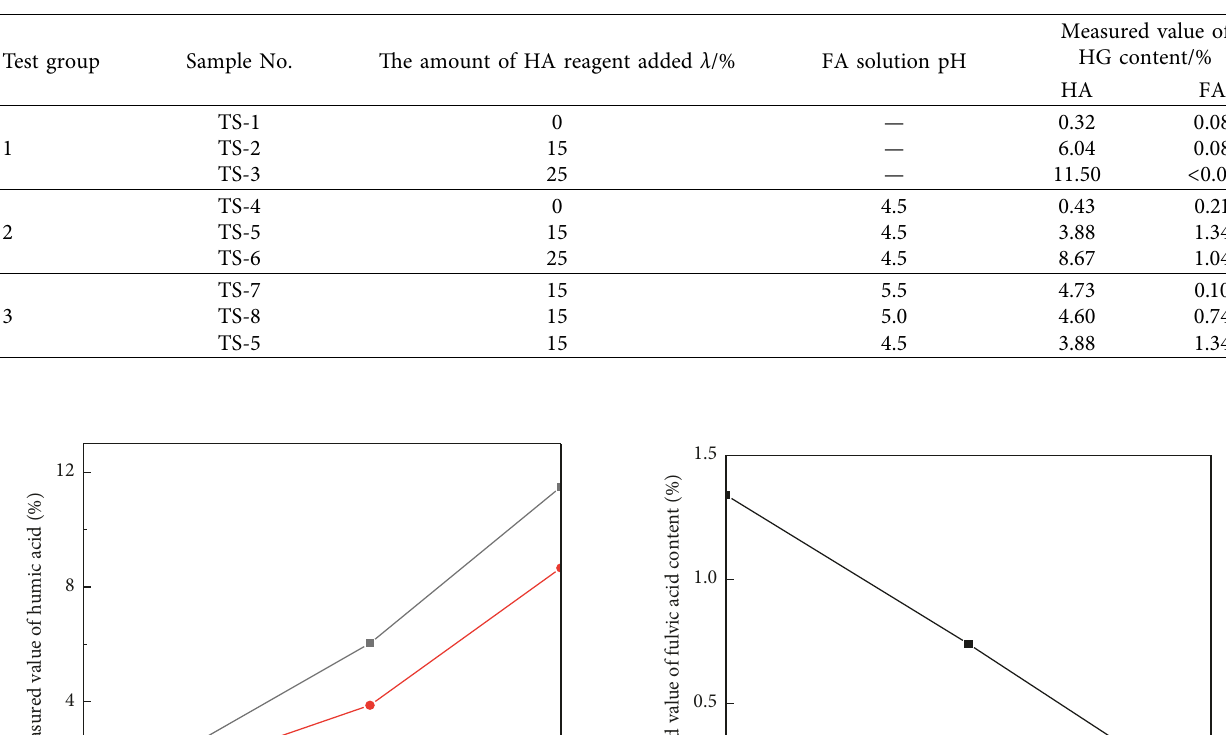
Table 5: Determination results of HG content of PSE simulation test.